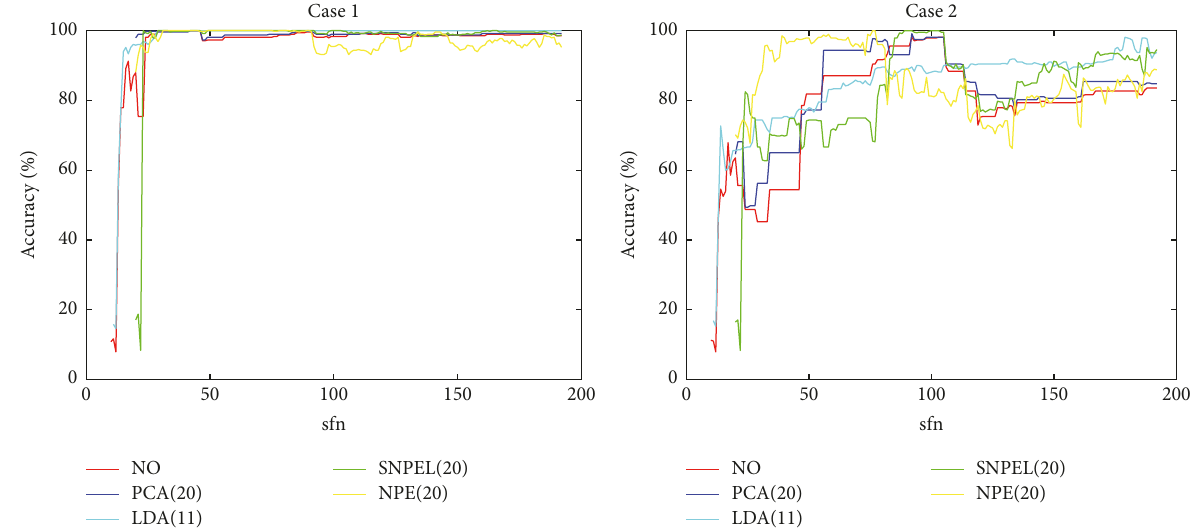
Figure 20: The diagnosis results of models using MODWPT for the testing sets of two cases with the use of FSASD and different dimensionality reduction methods. The output dimension sizes of PCA, LDA, and SNPEL are 20, 11, and 20, respectively. The “NO” represents the model without using dimensionality reduction